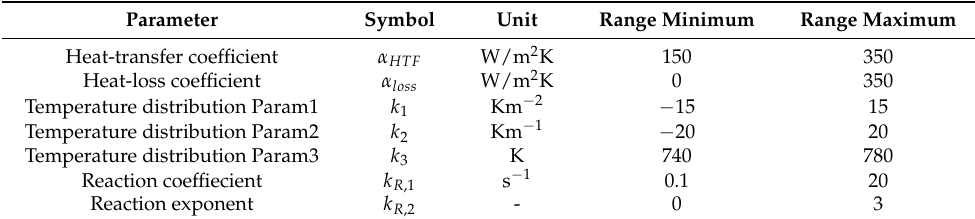
Table 5. Parameters chosen for